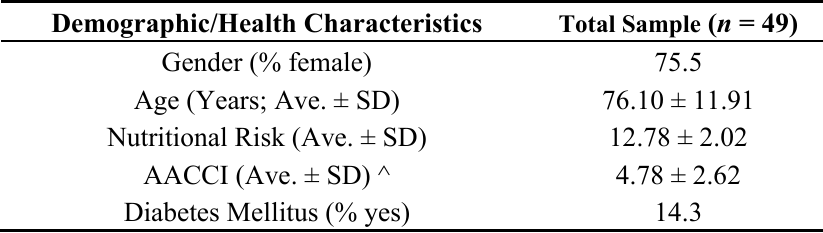
Table 2. Sample description for study participants ( n = 49).